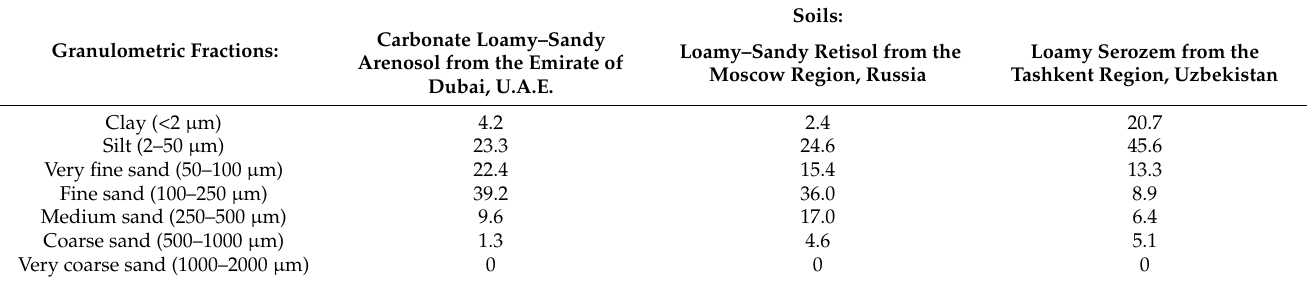
Table 1. Granulometric composition of upper (0–20 cm) soil